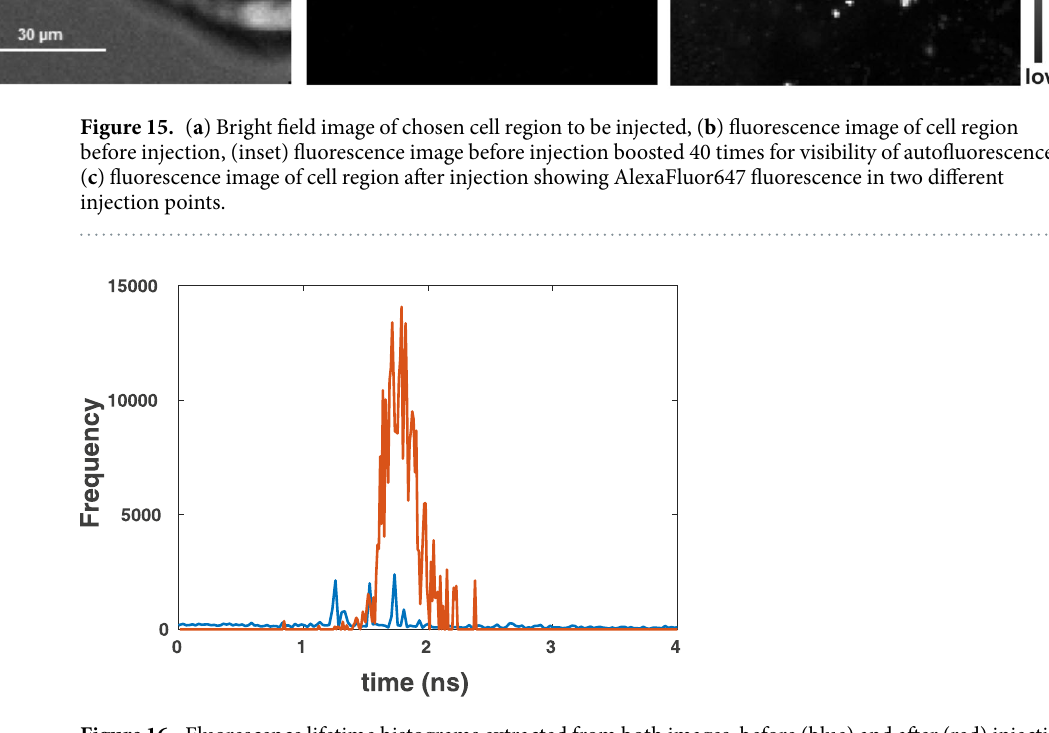
Figure 16. Fluorescence lifetime histograms extracted from both images, before (blue) and after (red) injection. Additional photon counts after injection and their lifetime distribution indicate successful injection process of AlexaFluor647-labeled